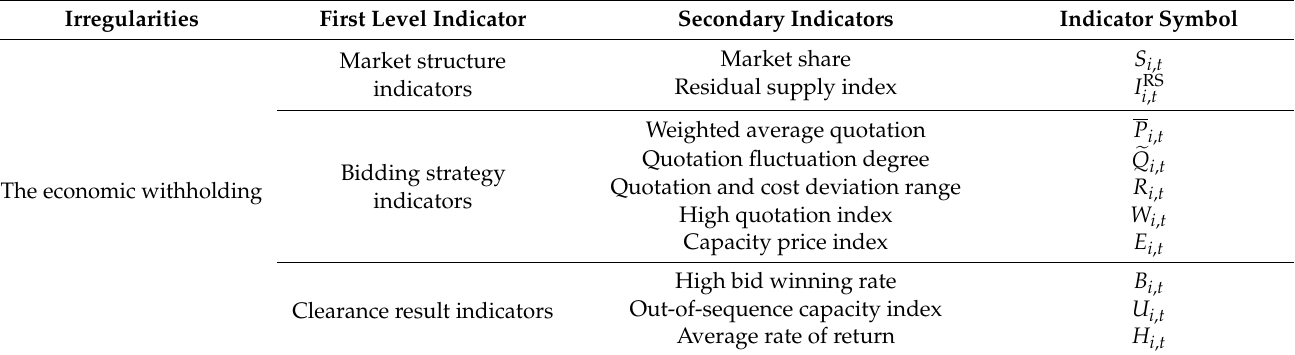
Table 1. An indicator system for identifying economic withholding behavior of the